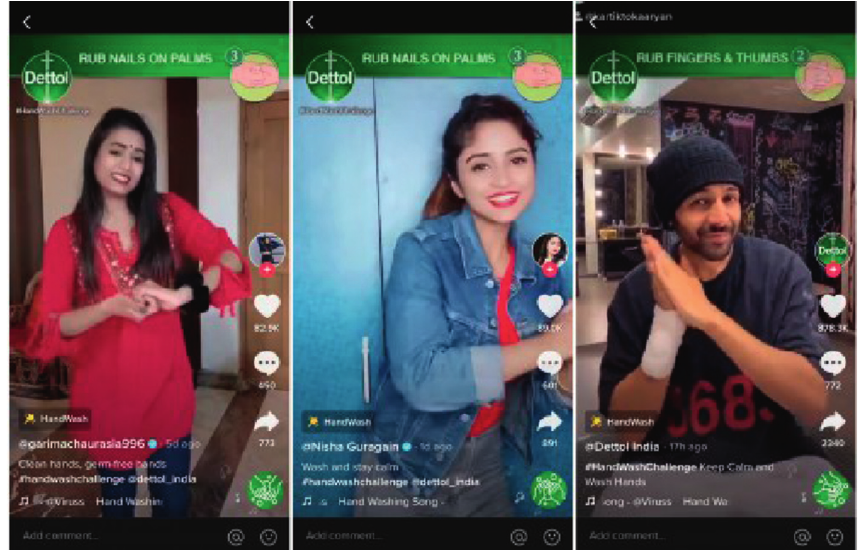
Figure 1: Short video software tik